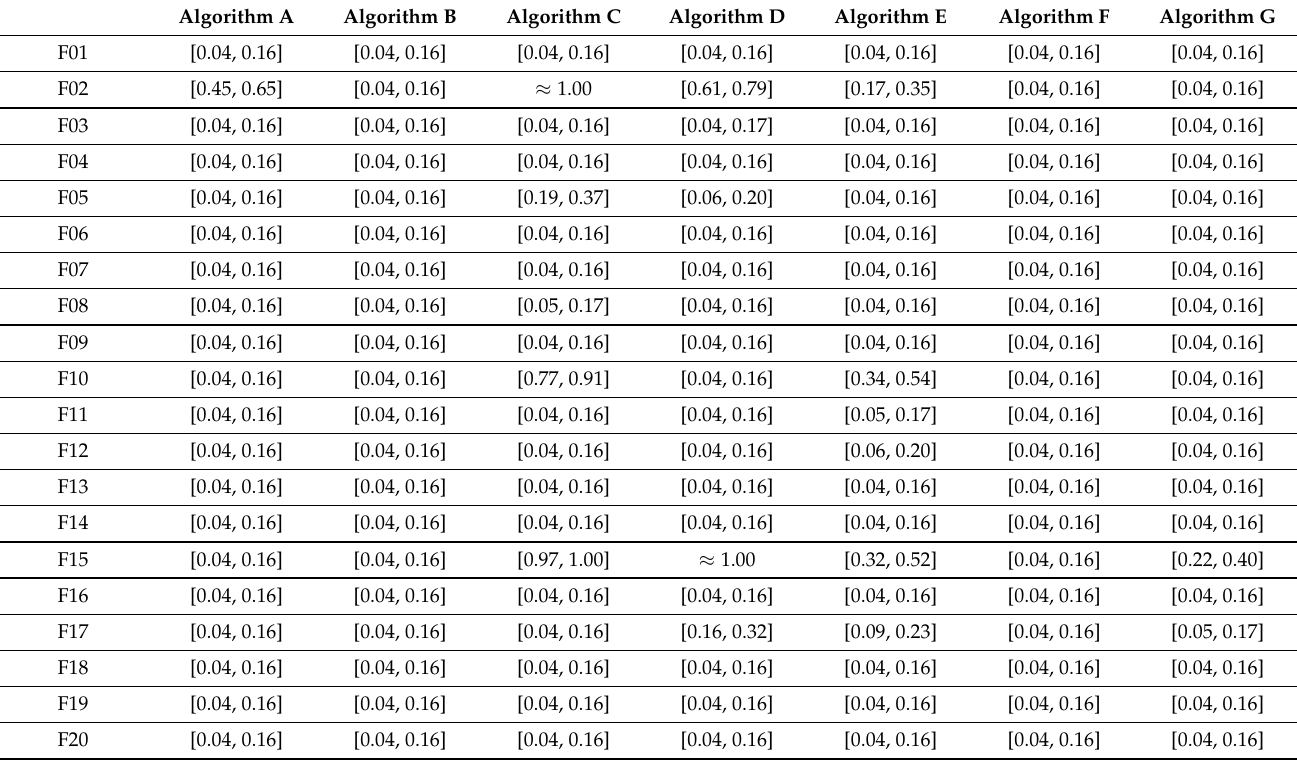
Table 14. Confidence intervals of the probability for sample quantiles Q 0.10 of solution quality.